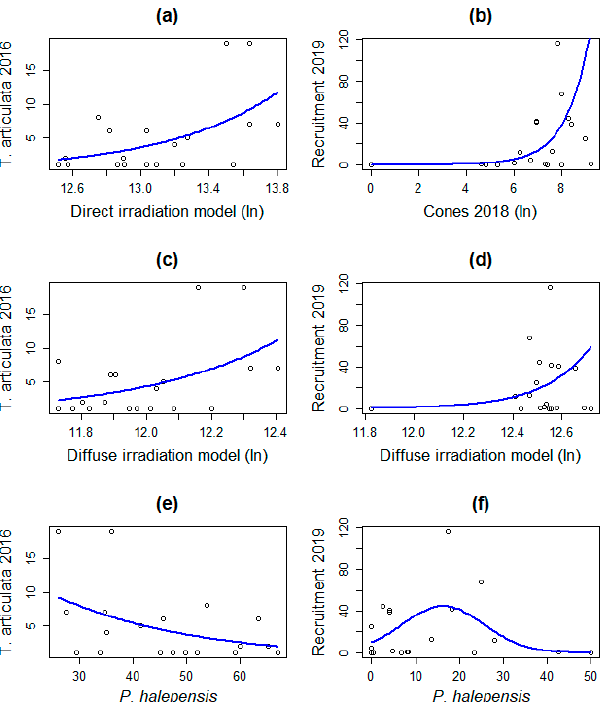
Figure 4. Fitted negative binomial GLM for significant variables (left: 2016, right: 2019). ( a ) Direct irradiation, ( b ) previous year cone production, ( c , d ) diffuse irradiation, and ( e , f ) Pinus halepensis canopy.